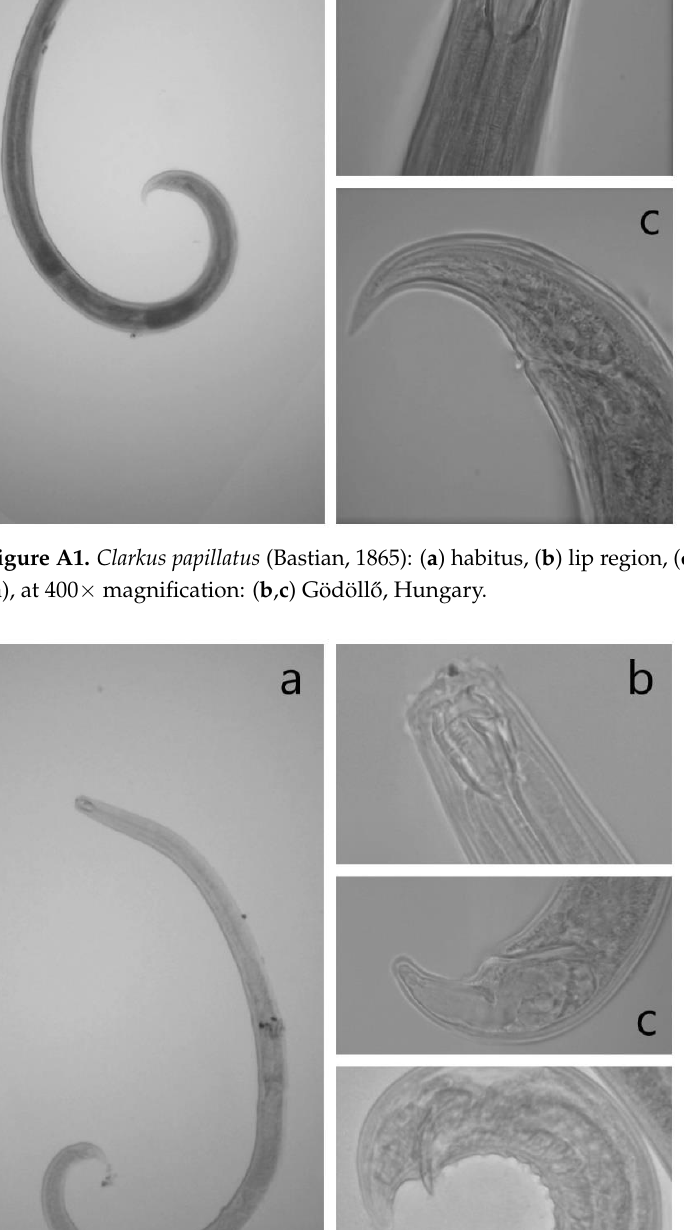
Figure A3. Prionchulus punctatus (Cobb, 1917): a . habitus, b . lip region, c . tail; at 200× magnification: a , at 400× magnification: b , c . Gödöllő, Hungary.